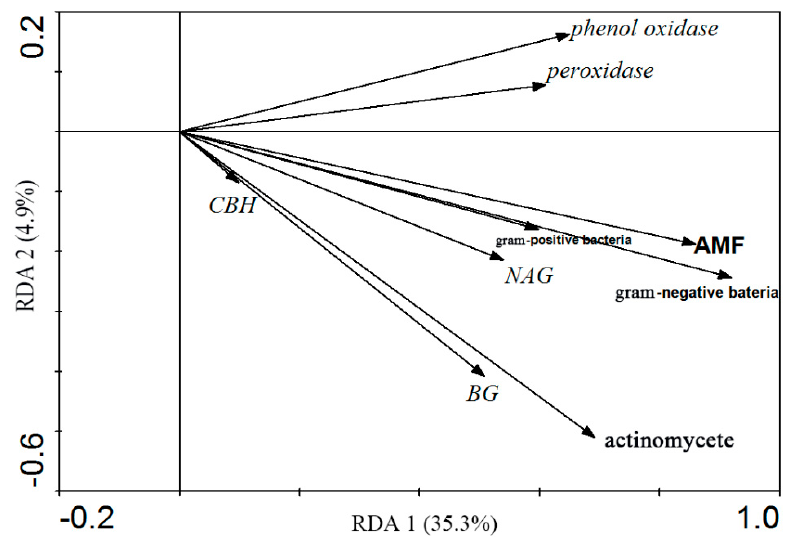
Figure 2. Redundancy analysis (RDA) ordination biplot of soil microbial community and soil enzyme activities. AMF: arbuscular mycorrhizal fungi; BG: β -glucosidase; NAG: N -acetyl- β -glucosidase; CBH: cellobiohydrolase. Table 5. Marginal and conditional effects of microbial composition on soil enzyme activities obtained from forward selection in redundancy analysis (RDA).